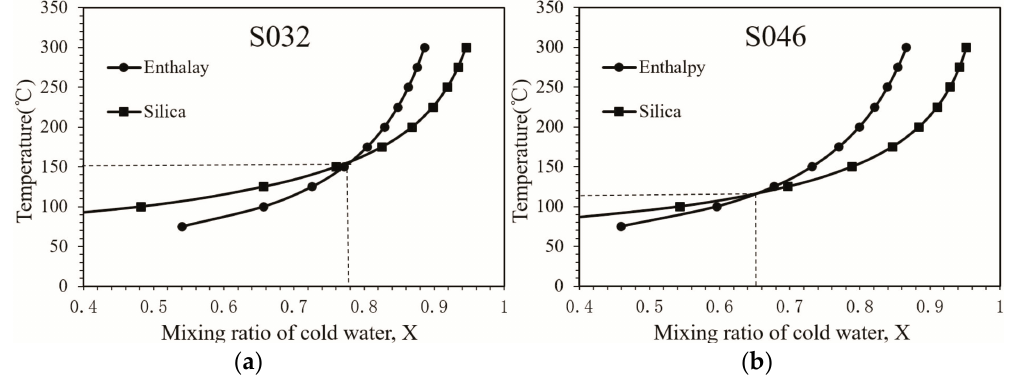
Figure 9. Relationship between the temperature and the mixing ratio of cold water for ( a ) S032 and ( b ) S046. The ratios of cold water mixing and reservoir temperature are shown in Table 5. The reservoir temperatures of the geothermal springs ranged from 82.0 to 165.0 °C, and the ratios of cold water mixing ranged from 0.54 to 0.87. Although some springs had high reservoir temperatures, i.e., up to 165.0 °C, the outlet temperatures were relatively low due to different amounts of cold water mixing. Table 5. Estimated reservoir temperature and cold water mixing ratio.